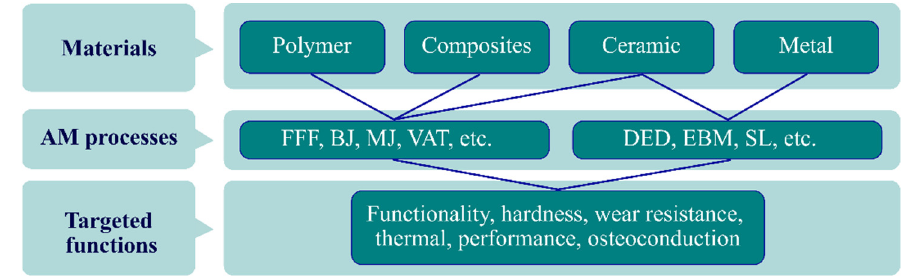
Figure 1. Overview of manufacturing and property enhancement possibilities of MMAM.